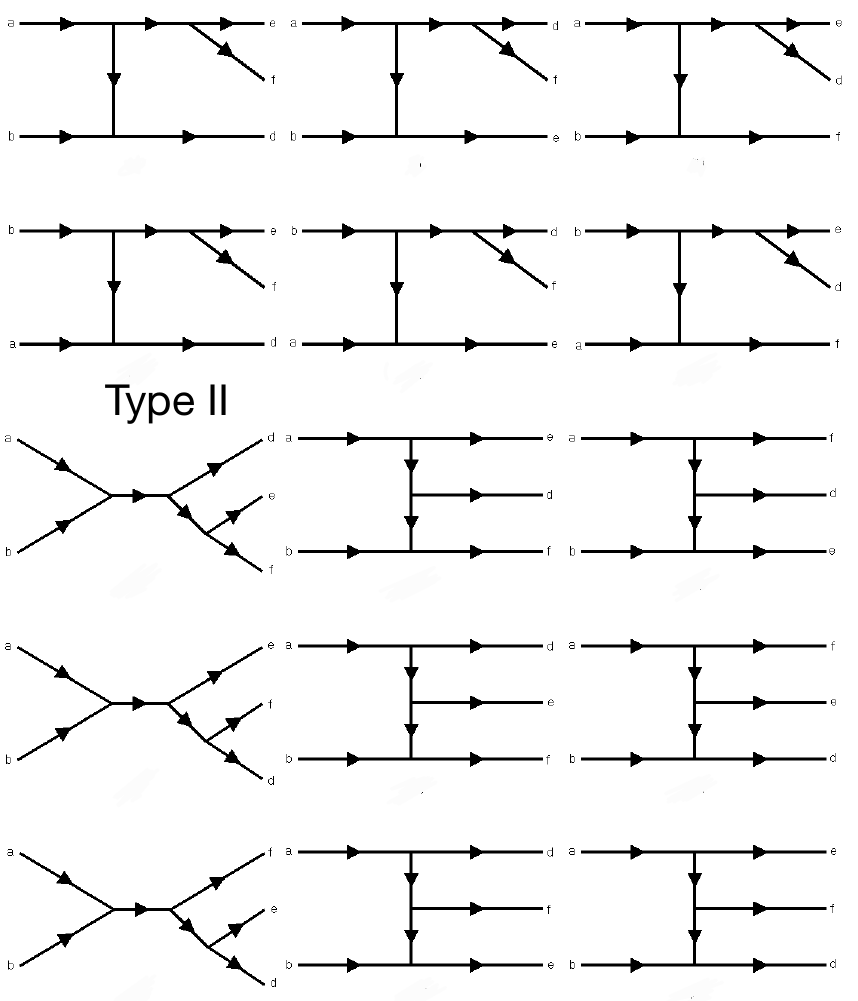
Figure 6. Type II diagrams are formed by three three-phonon vertices of L LO . Figure adapted from